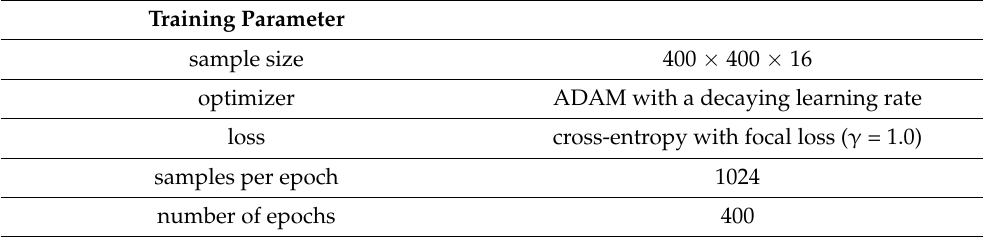
Table 1. Training parameters of the neural network.